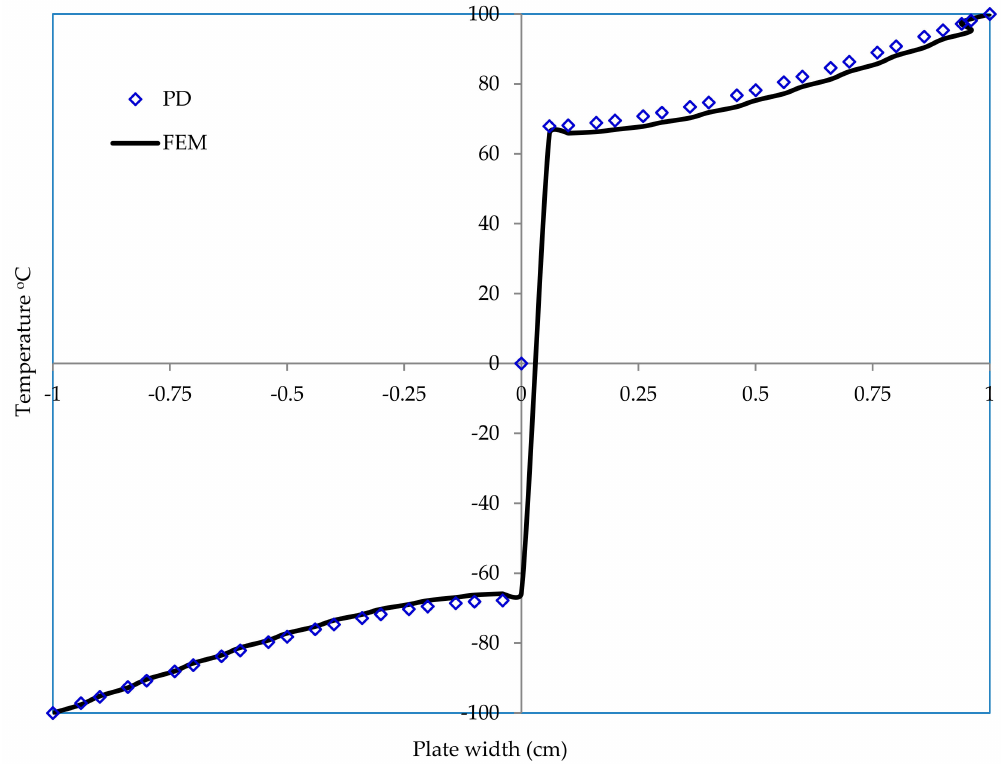
Figure 16. Temperature distribution along x = − 0.5.